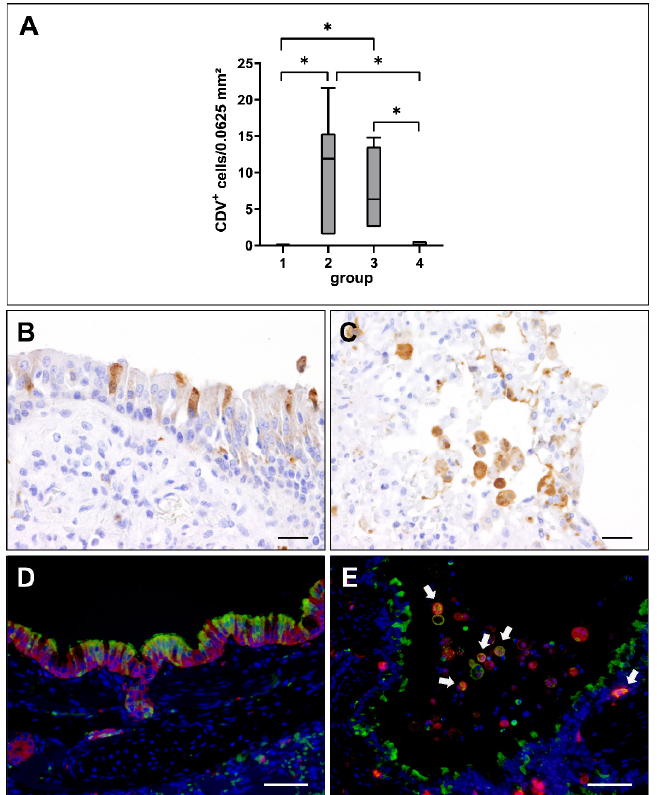
Figure 2. Canine distemper virus (CDV) loads and distribution in the lung. ( A ) Quantification of CDV antigen at different phases of infection. Note significant increase of CDV loads in the acute (group 2) and subacute infection phase (group 3), followed by a decrease in the subacute-chronic phase (group 4). Groups: 1 = non-infected controls; 2 = acute CDV infection; 3 = subacute CDV infection; 4 = subacute-chronic CDV infection; box and whisker plots display median and quartiles with maximum and minimum values. Significant differences ( p ≤ 0.05, Kruskal–Wallis H test) are labelled by asterisks. ( B , C ) Immunohistochemistry revealed CDV antigen within airway epithelial cells ( B ) and intraalveolar cells ( C ). ( D , E ) Detection of CDV antigen (green) and cytokeratin (epithelial cells, red, D ) and Iba ‐ 1 (histiocytic cells, red; CDV + histiocytes, white arrows, E ) by immunofluorescence. Nuclei were counterstained with bisbenzimide (blue). Scale bars: ( B , C ): 20 μ m. ( D , E ): 50 μ m.